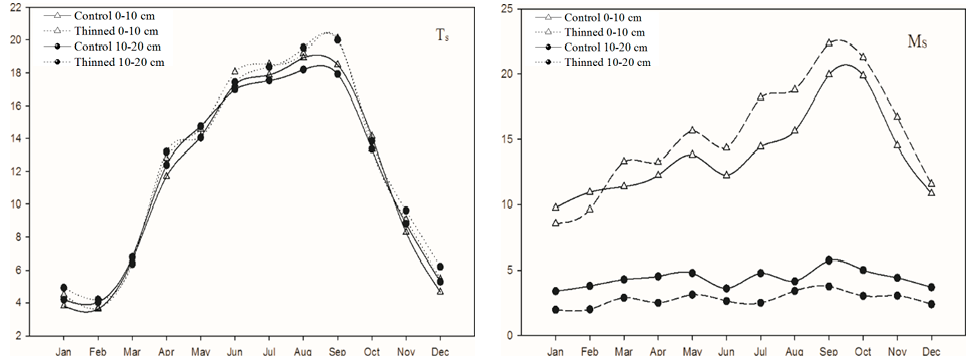
Figure 2. Soil temperature (°C) and moisture (% volume) at depths of 0–10 and 10–20 cm in the control and thinned plots (Ts and Ms are soil temperature and soil moisture, respectively). Solid and dashed lines represent control and thinned plots, respectively. Open triangles and closed circles represent 0–10 and 10–20 cm soil depths, respectively.